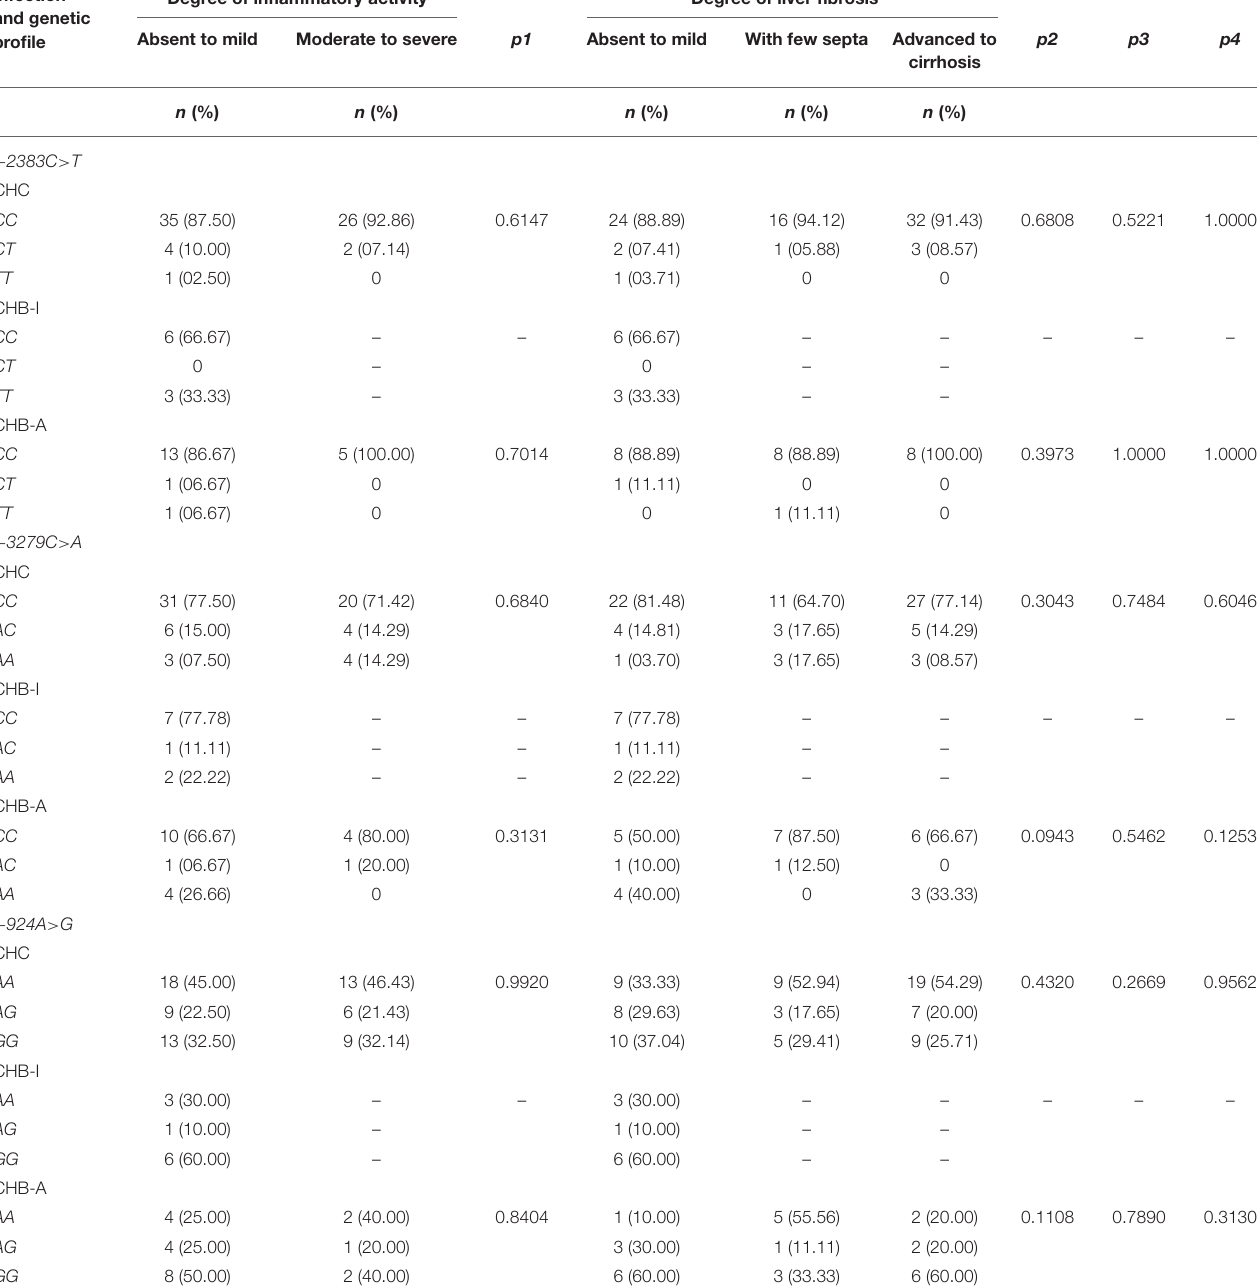
TABLE 4 | Frequency of polymorphisms in the FOXP3 gene promoter region according to the histopathological characteristics of patients with chronic hepatitis B and C virus infections. Infection and